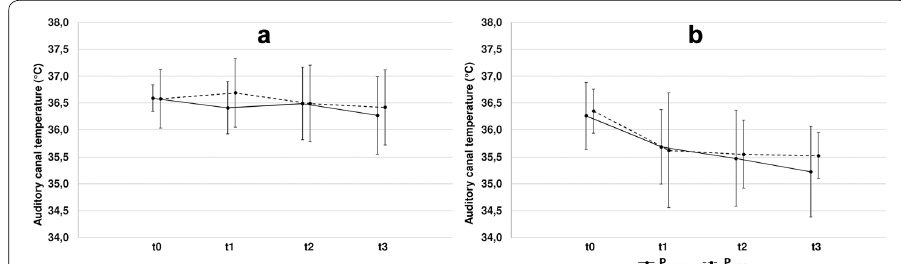
Fig. 4 Auditory canal temperature as measured after warm-up (t0) and after 15 min (t1), 30 min (t2) and 45 min (t3) of running for the thermally insulating (P INSUL ) and non-insulating (P COOL ) pants worn in studies A ( a ) and B ( b ). No significant differences were found between P INSUL and P COOL but factor time was significant